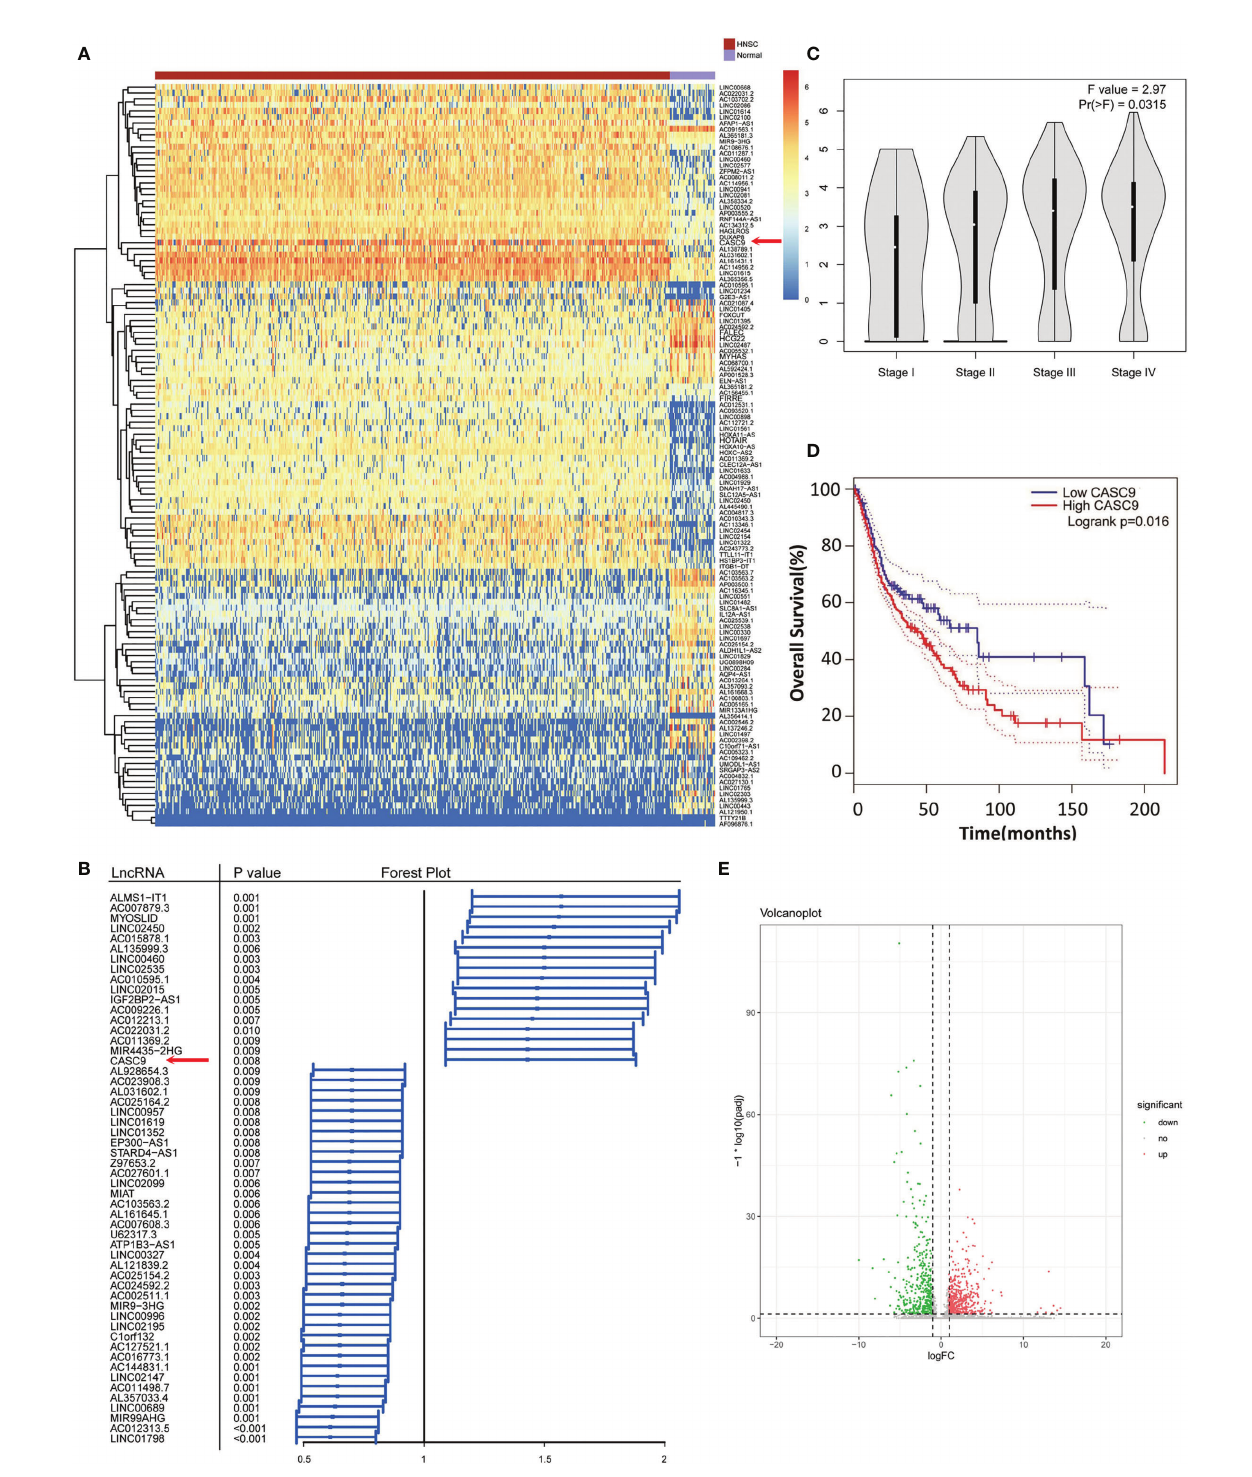
FIGURE 1 | CASC9 were overexpressed and predicted adverse clinical outcomes in HNSC and NPC based on bioinformatics analysis. (A) The DElncRNAs in TCGA-HNSC dataset were shown in the thermograph, including CASC9. (B) Forest plot of the prognosis-associated DElncRNAs including CASC9( P < 0.008). (C) Higher CASC9 expression was related to advanced TNM staging in HNSC. (D) Higher CASC9 expression was related to HNSC patients ’ shorter OS. (E) Volcano Plot visualized the DElncRNAs in